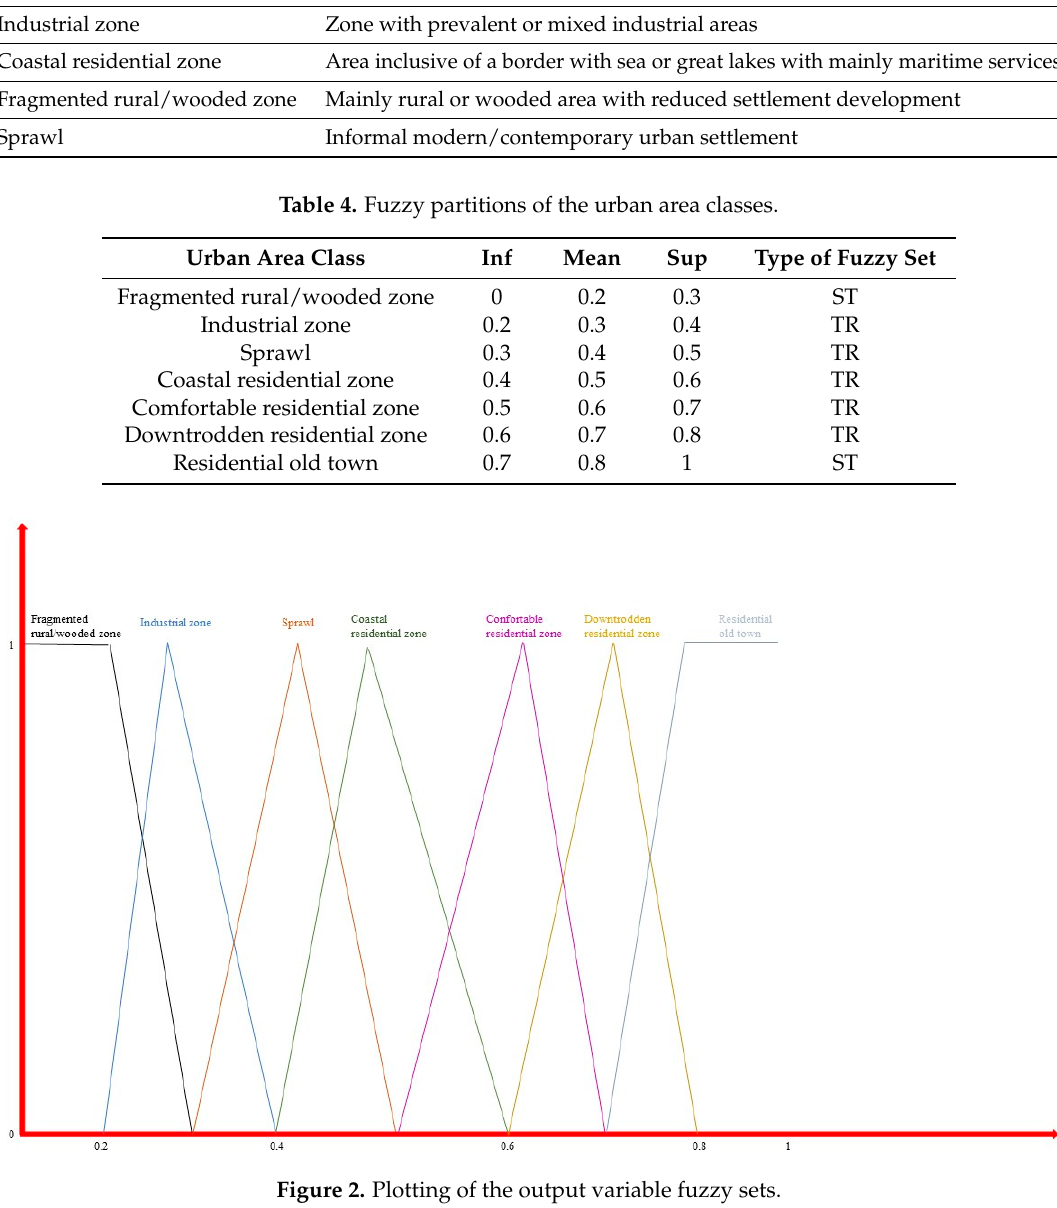
Figure 2. Plotting of the output variable fuzzy sets.